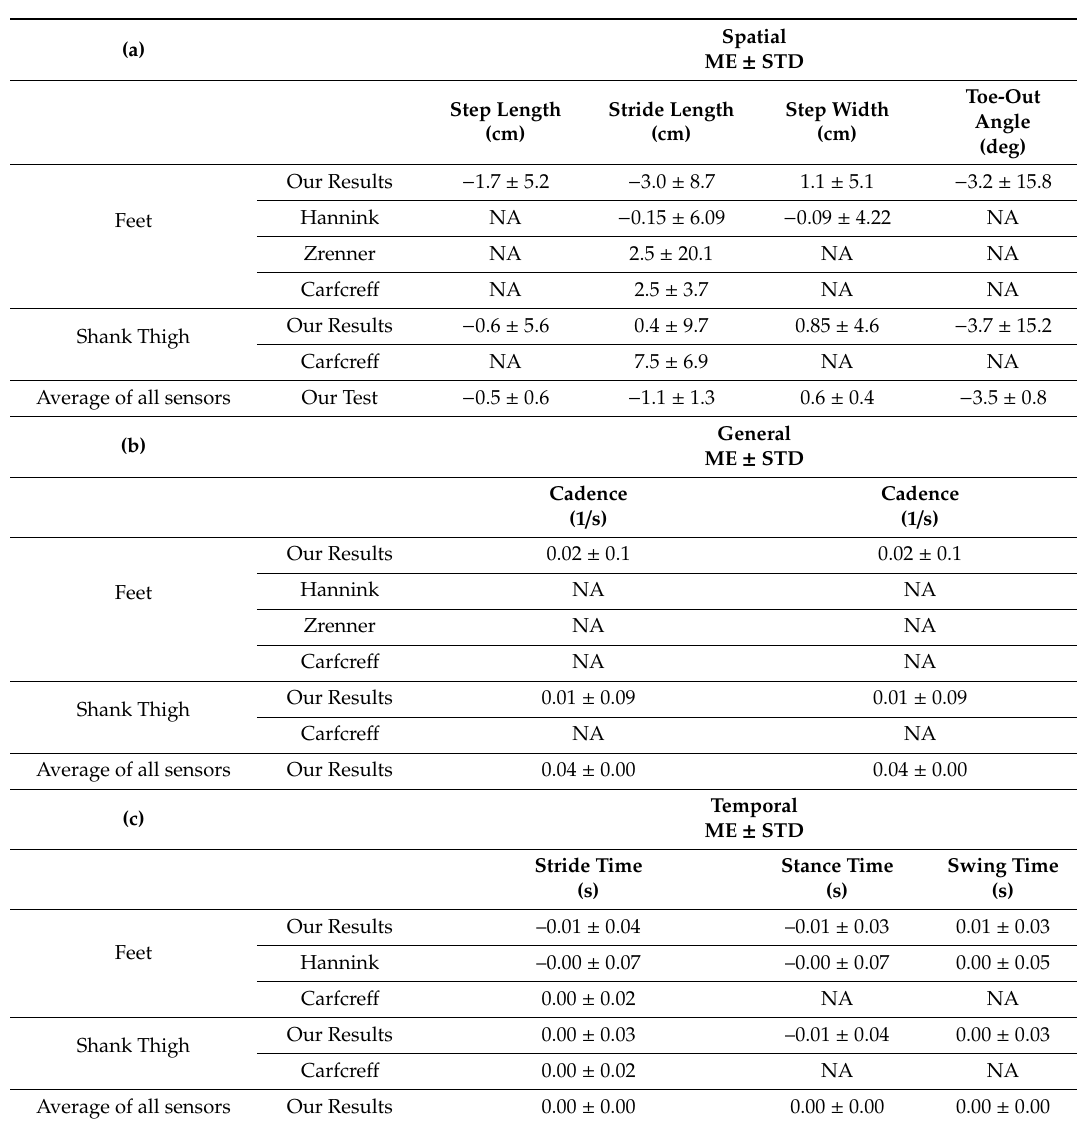
Table7. Deep-learningaccuracycomparisonwithpreviousstudiesfor( a )spatialparameters, ( b )general, and ( c ) temporal